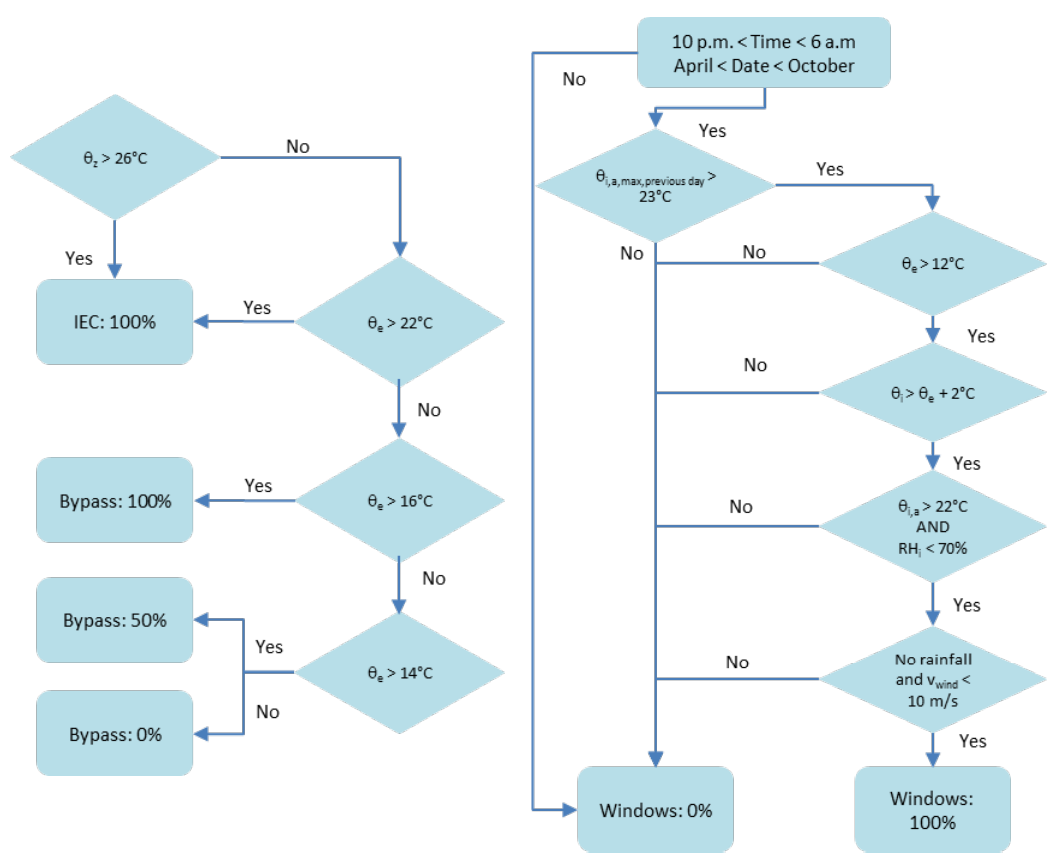
Figure 5. Control strategy flowchart of AHU during occupancy ( left ) and natural night ventilation ( right ).